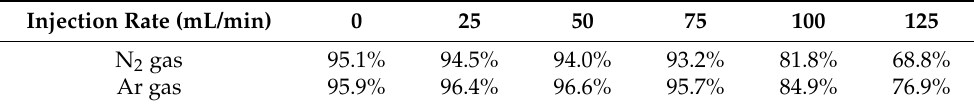
Table 1. The ratio of sintered/melted area of the patterns fabricated under N 2 and Ar gases at different injection